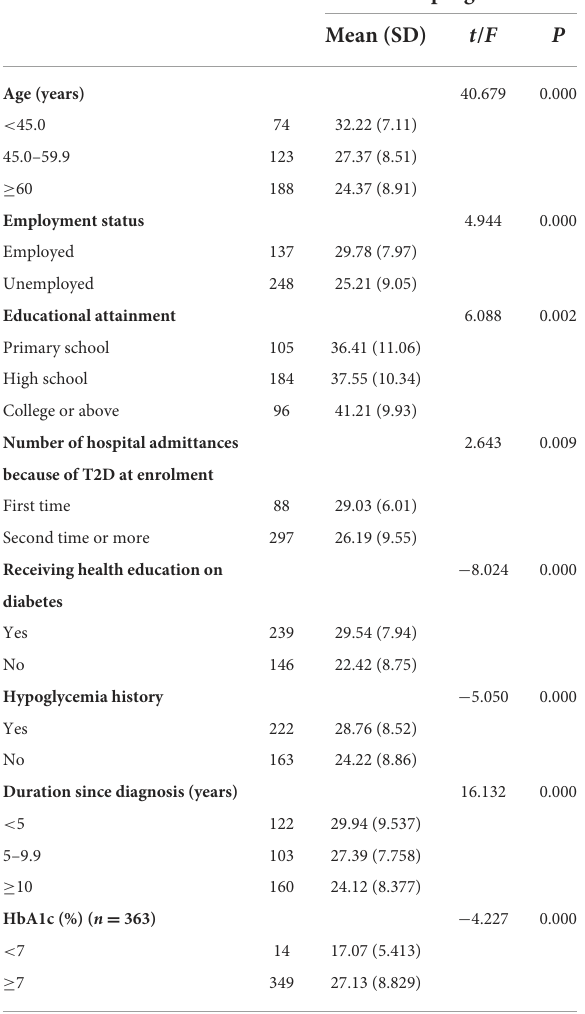
TABLE 3 Differences in fear of progression among various socio-demographic and clinical sub-groups ( n = 385).